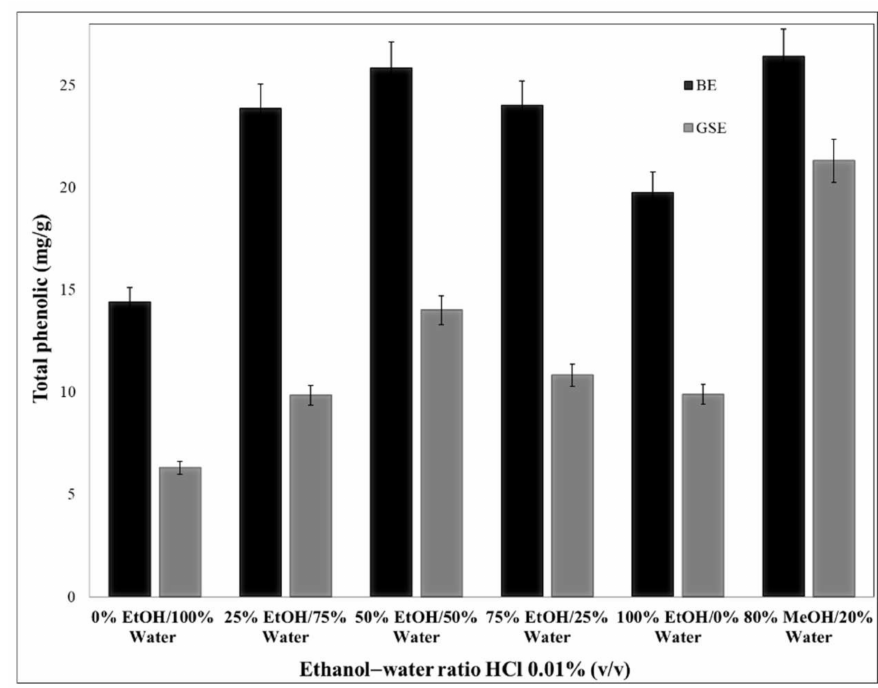
Figure 3. Variation in polyphenol content by solvent concentration.